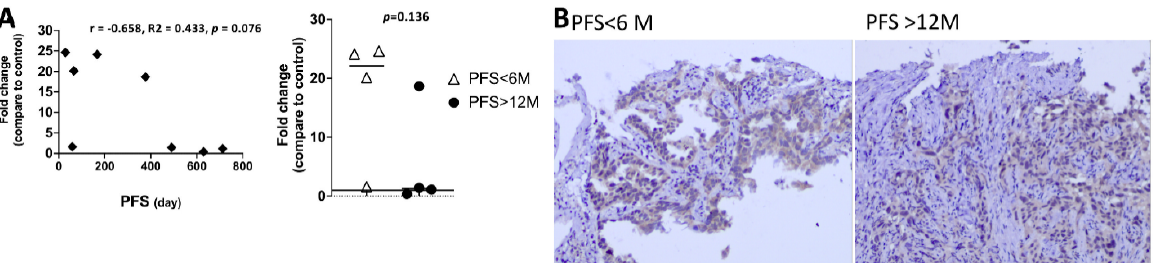
Figure 7. The EGFR-mutation abundance analysis using real-time PCR and immunohistochemistry staining. ( A ) To calculate the relative expression of the EGFR-mutant mRNA normalized to internal control (exon 2), the average of target Ct was subtracted from the average of Exon 2 Ct ( ∆ Ct). The amount of EGFR-mutant mRNA normalized to an endogenous reference and relative to a calibrator (fold-change) is given by 2 − ∆∆ Ct where the calculation of ∆∆ Ct involves subtraction by the ∆ Ct calibrator value. Assuming that ∆ Ct = 3.32 corresponds to a 10-fold difference of expression between exon 2 and EGFR. There was no correlation between relative EGFR-mutation abundance and PFS of patients receiving EGFR-TKI analyzed by Pearson’s correlation coefficient (r) method. In addition, EGFR-mutation abundance in a poor responder (PFS < 6 months) and good responder (PFS > 12 months) are also not different. Student’s t-test was used. ( B ) Immunohistochemical staining of EGFR 19Del specific protein showed similar intensity in tumors from patients with different response to EGFR-TKI (Magnification, 200×).